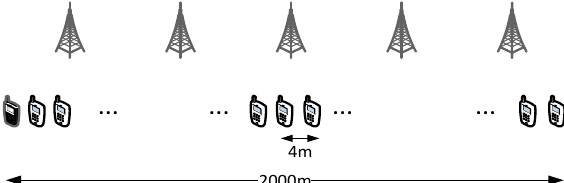
Figure 25. Simulation scenario for P2MP D2D transmissions.